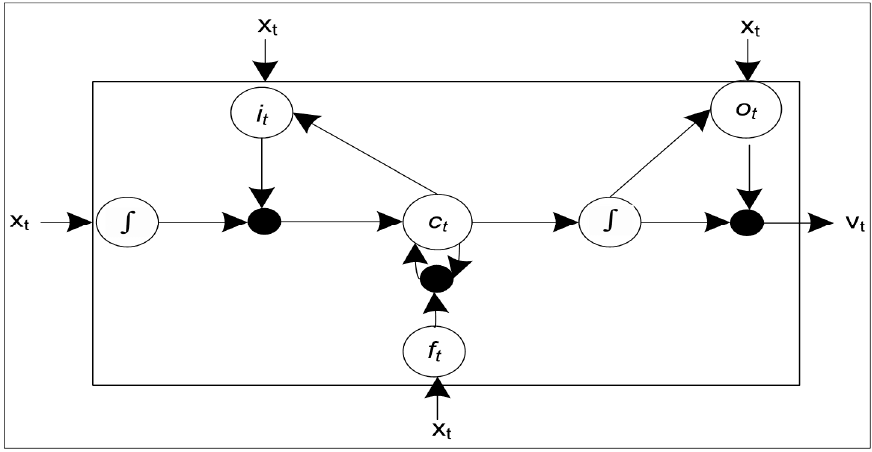
Figure 4. An LSTM cell structure .